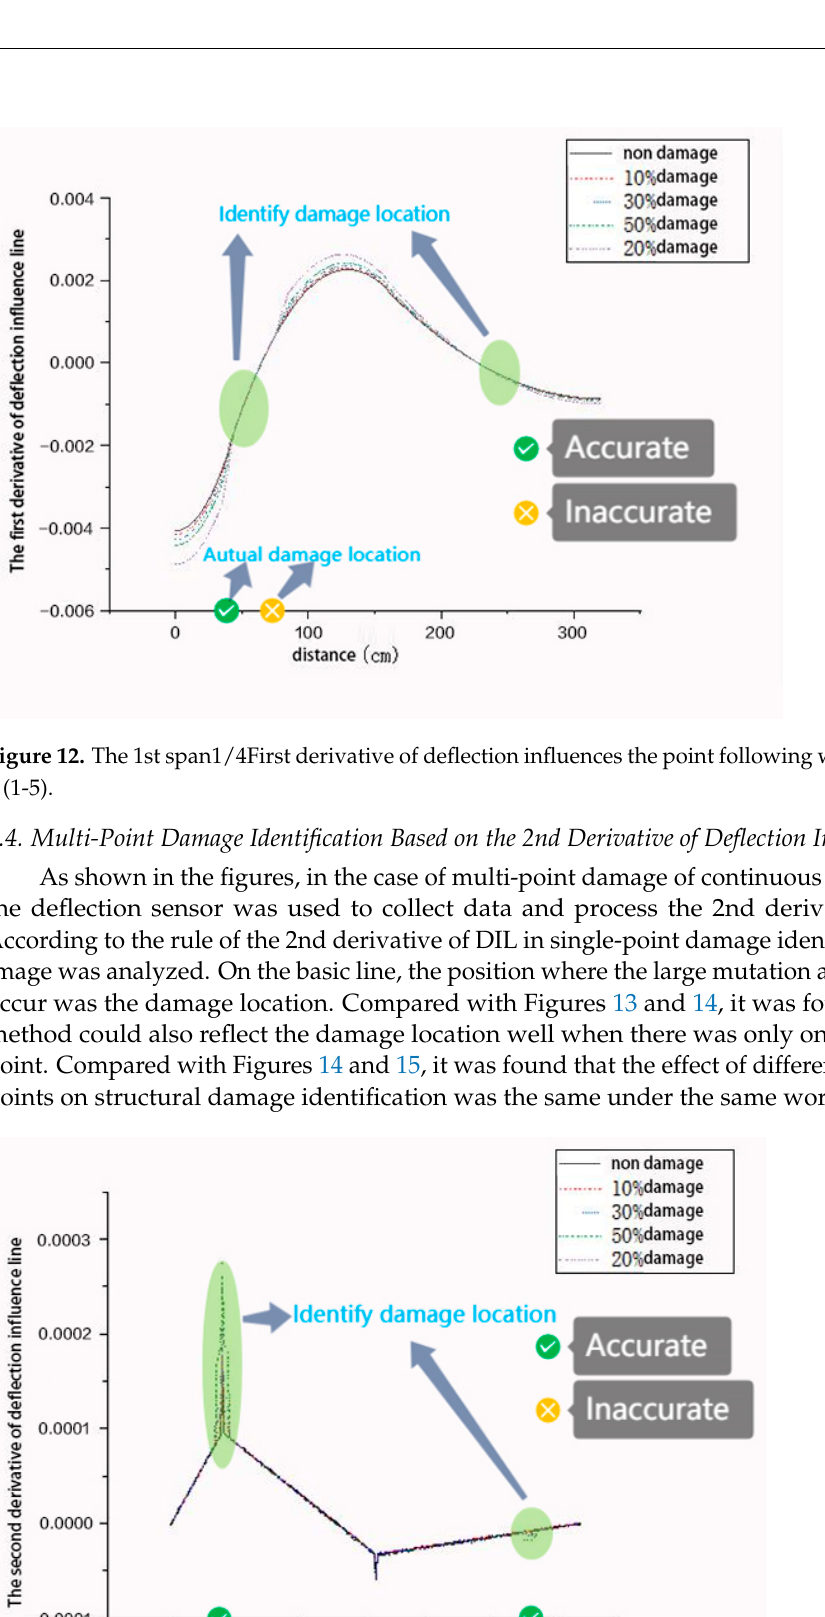
Figure 14. The 2nd derivative of deflection influence line at 1/4 determining point of the 1st span following work condition 2 (2-5).